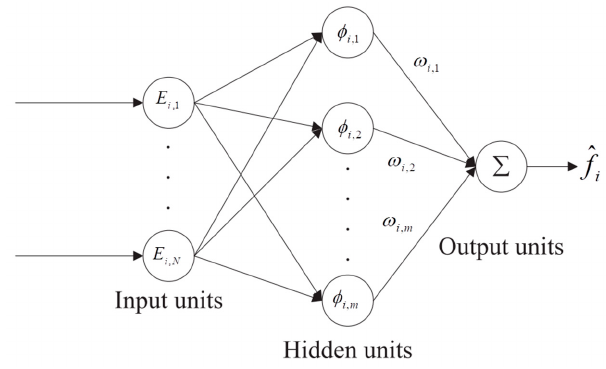
Figure 4. The layout of an RBF neural network.